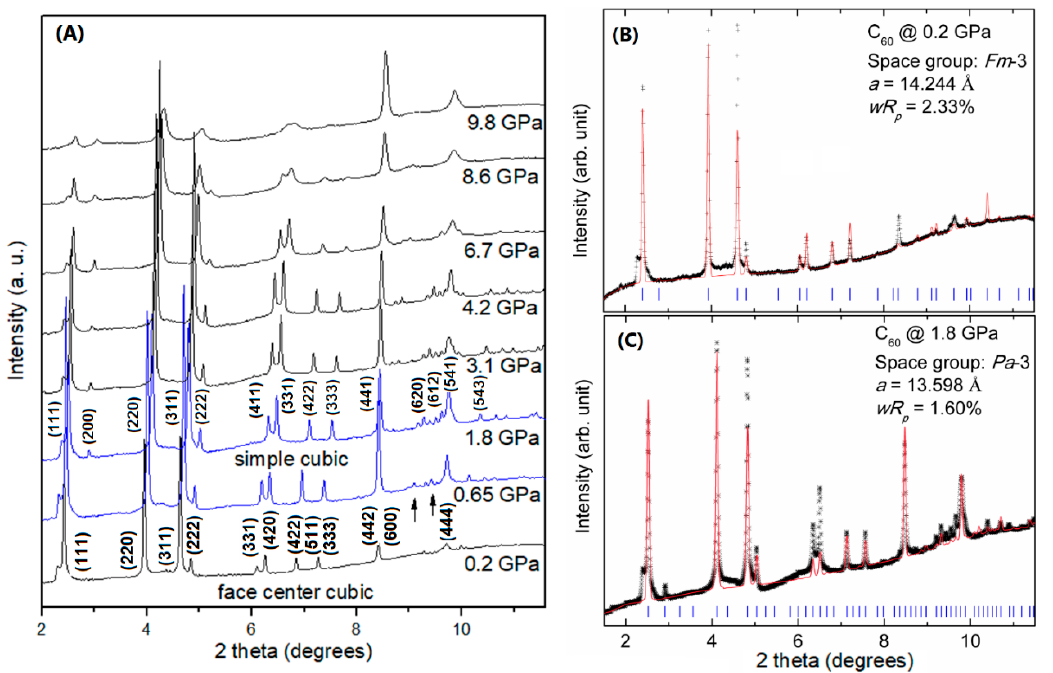
Figure 3. X-ray diffraction of C 60 at high pressures ( A ), and refinements of the diffraction spectra at 0.2 GPa ( B ) and 1.8 GPa ( C ), 0.2 GPa ( B ) and 1.8 GPa ( C ), respectively.